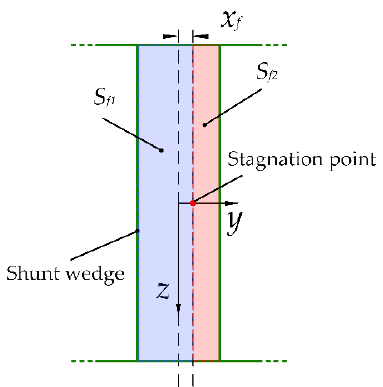
Figure 9. Solid impact surfaces on the shunt wedge.